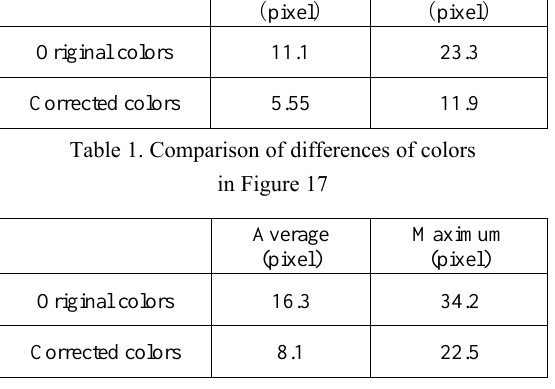
Table 2. Comparison of differences of colors in Figure